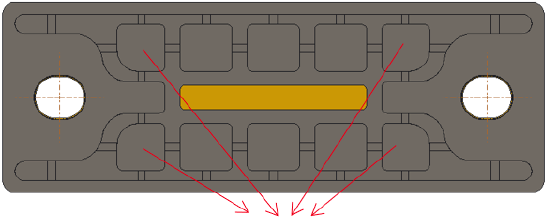
Figure 2. Second-order stiffness design.